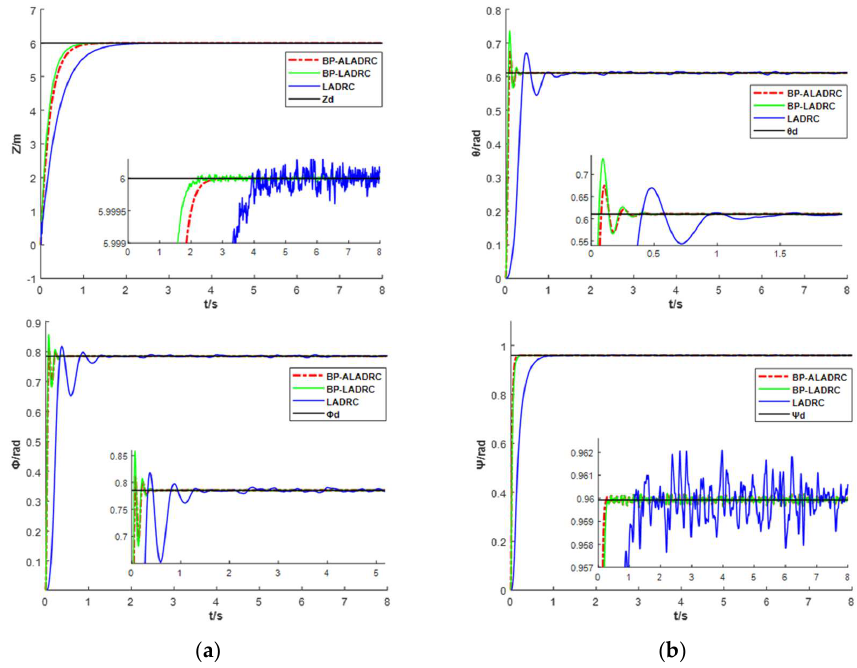
Figure 7. System output: (a) Altitude and Roll angle output; (b) Pitch and Yaw angle output.